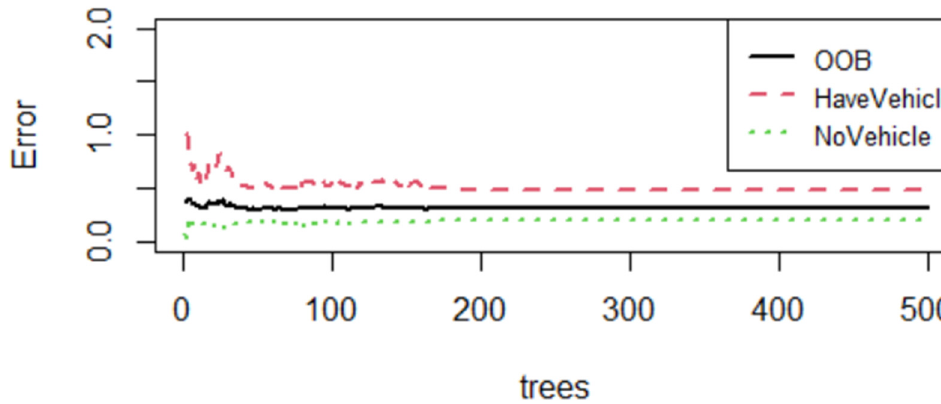
Figure 9. Error rates using random forest from 191 videos.